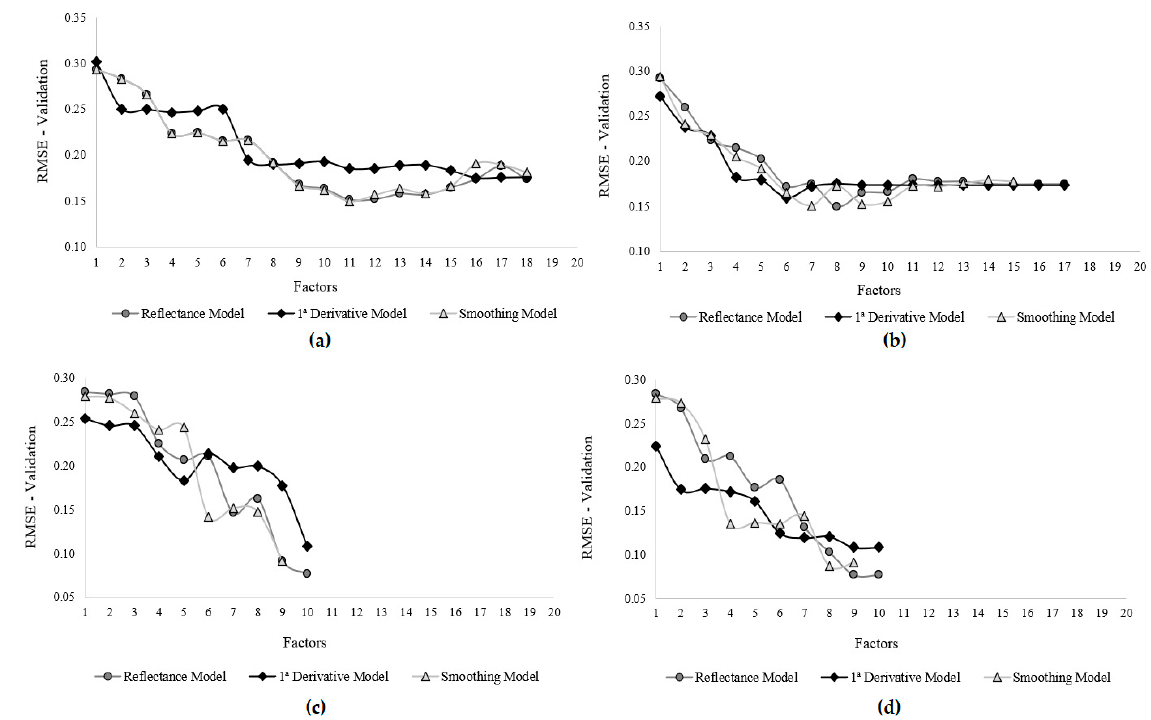
Figure 15. RMSE in SOC prediction for models using samples from A1 for ( a ) full-spectrum PCR; ( b ) full-spectrum PLSR; ( c ) PCR after Stepwise Forward; and ( d ) PLSR after Stepwise Forward.